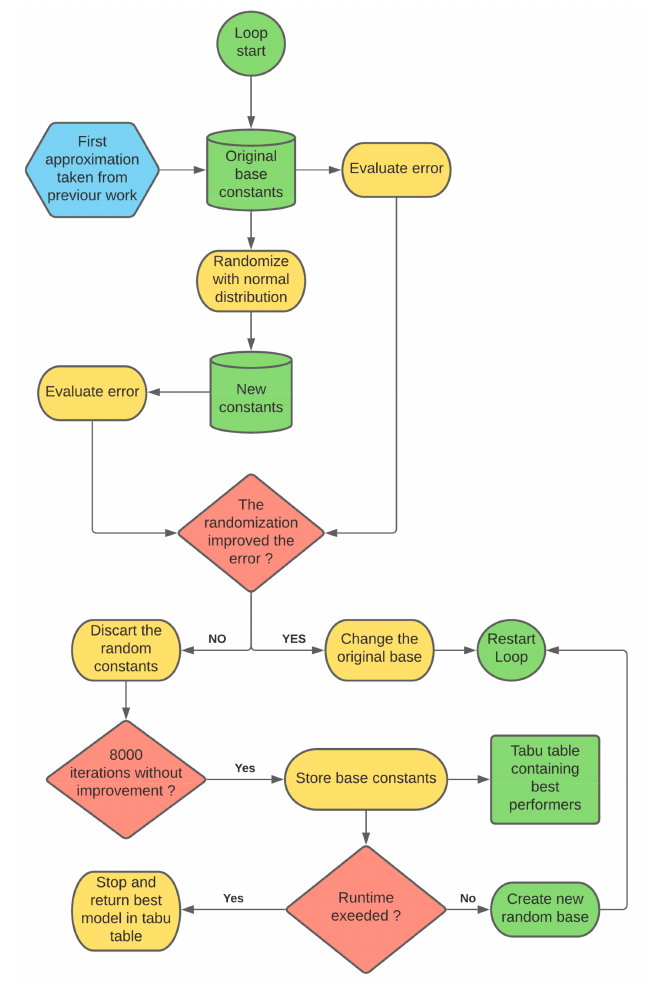
Figure 7. Metaheuristic process for parameter selection